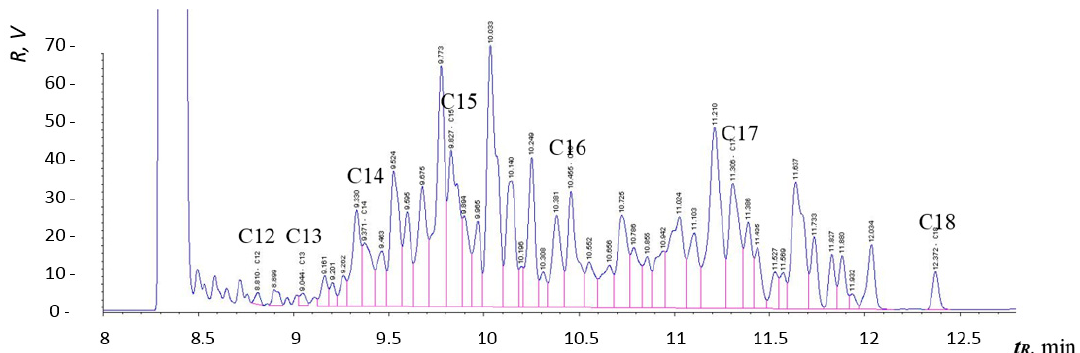
Figure 13. Chromatogram of 100% HVO with identified (labeled) n-alkanes.